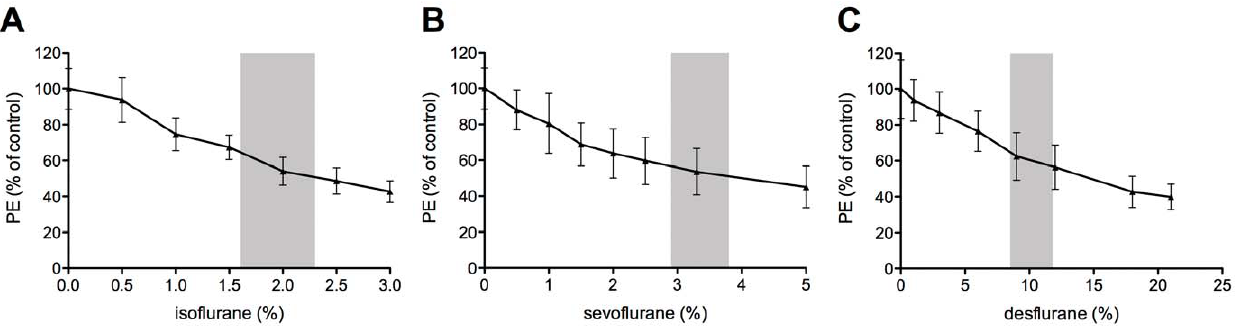
Figure 1. Effect of volatile anesthetics on BLI signal. The effect on photon emission (PE) of isoflurane ( A ), sevoflurane ( B ) and desflurane ( C ) anesthetics is expressed relative to control samples, containing 100% oxygen without inhalation anesthetic. Intact cells were used. Grey intervals in the curves indicate the in vivo dose ranges. doi:10.1371/journal.pone.0030061.g001 PLoS ONE |